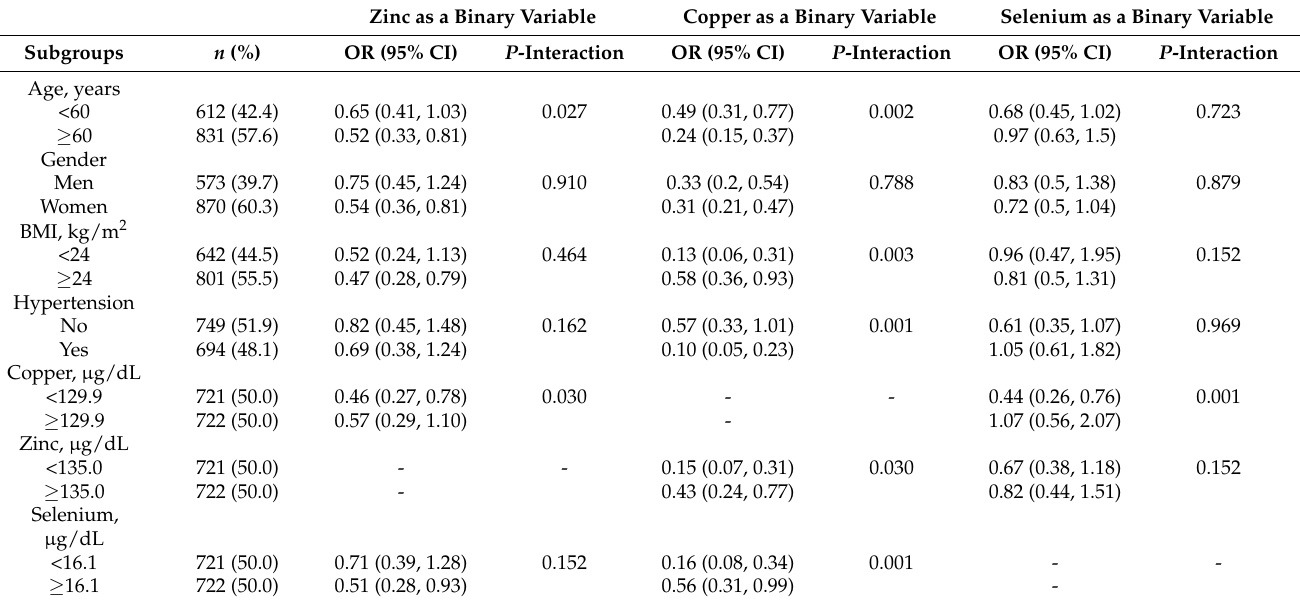
Table 3. Subgroup analyses of the association of serum zinc, copper and selenium with T2DM stratified by age, gender, BMI, hypertension and serum minerals.